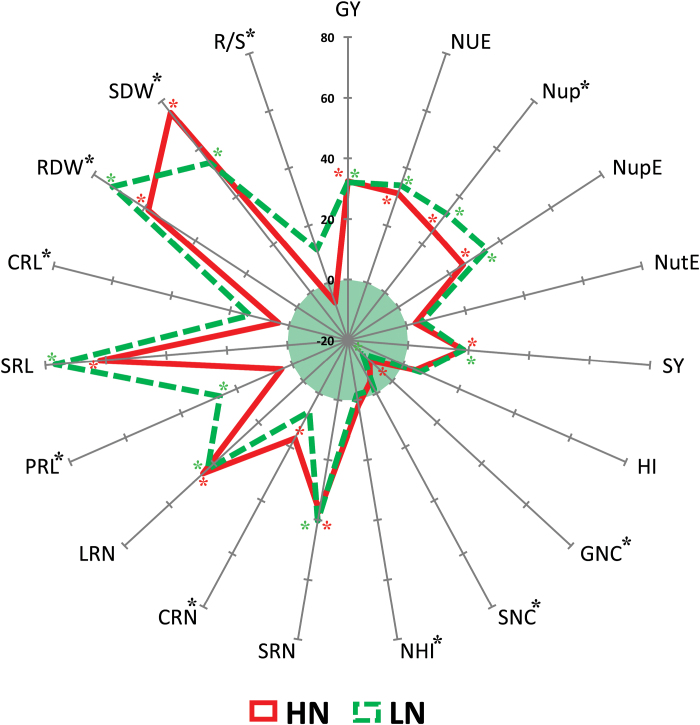
The phenotypic difference between the two parental lines Ye478 and Wu312 under HN and LN levels. The difference for each trait is indicated by the relative increase or decrease of Ye478 to Wu312, which was calculated as (Ye478 − Wu312)/Wu312×100%. The red solid line and green dotted line represent the percentages under HN and LN levels, respectively. A signiﬁcant difference between the two parents at HN level is labelled by a red asterisk and at LN level by a green asterisk. Traits that showed a signiﬁcant difference between two N levels are labelled by a black asterisk (*P < 0.05).